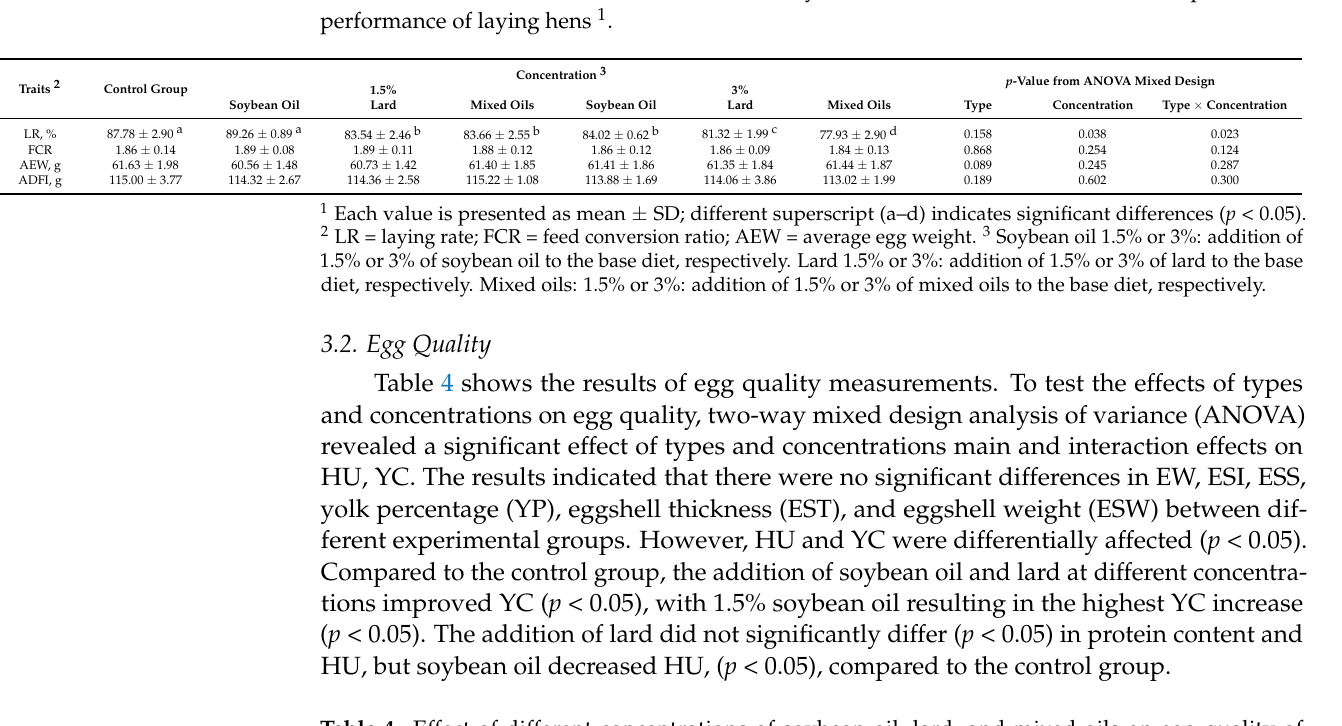
Table 4. Effect of different concentrations of soybean oil, lard, and mixed oils on egg quality of laying hens 1